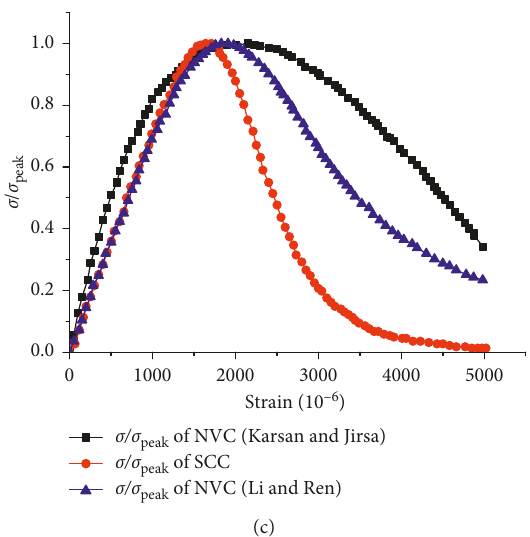
Figure 11: Comparison of the mean probability density P . (a) Probability density. (b) Plastic-damage variable dr . (c) Stress responses among SCC and two typical NVCs [19, 29] under compression.